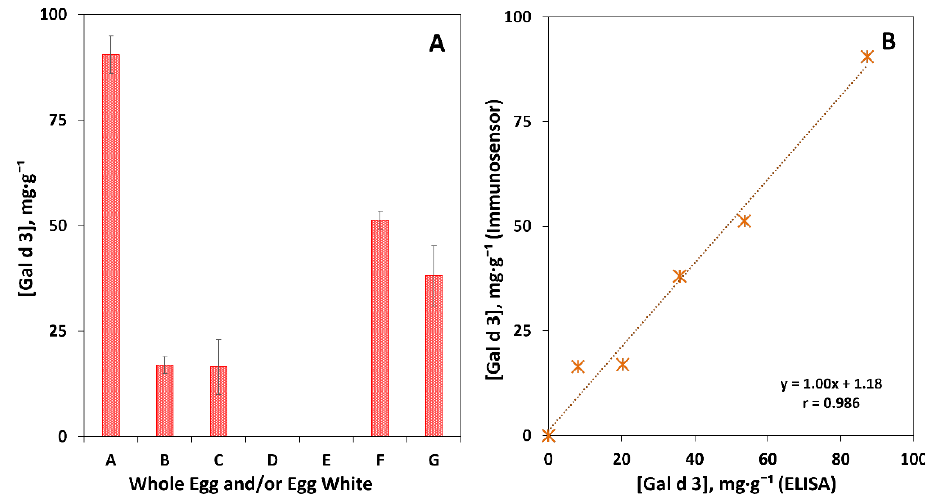
Figure 5. Quantification of Gal d 3 in egg. ( A ) Egg white: A—liquid, B—powder, C—boiled, D—fried, E—poached, F—whipped, and G—whole egg (yolk and white). ( B ) Correlation between the results obtained using the amperometric immunosensor and ELISA. The concentrations of the allergen (mg · g − 1 ) in these samples were: (A) 90.5 ± 4.4 (CV = 4.9%), (B) 17.0 ± 1.6 (CV = 9.4%), (C) 16.5 ±